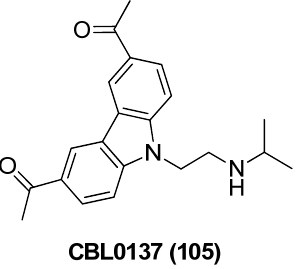
Figure 25. Chemical structure of carbazole derivative CBL0137 (105).